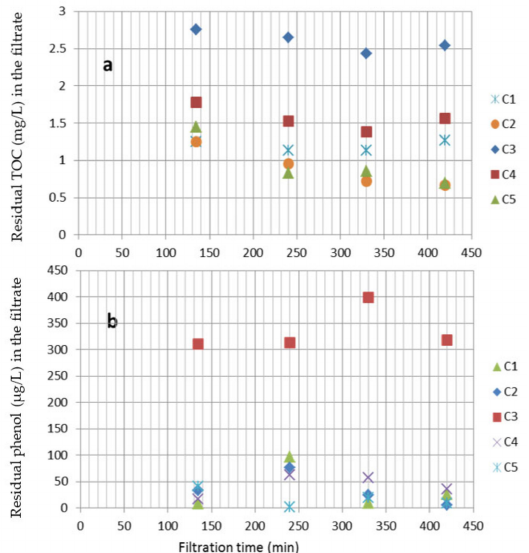
Figure 11. Residual concentration of contaminants in the filtrate over time for all filter configurations. ( a ) TOC, raw water TOC concentration = 3.369 mg / L; ( b ) phenol, raw water phenol concentration = 245.3 µ g / L (reprepared using the data from